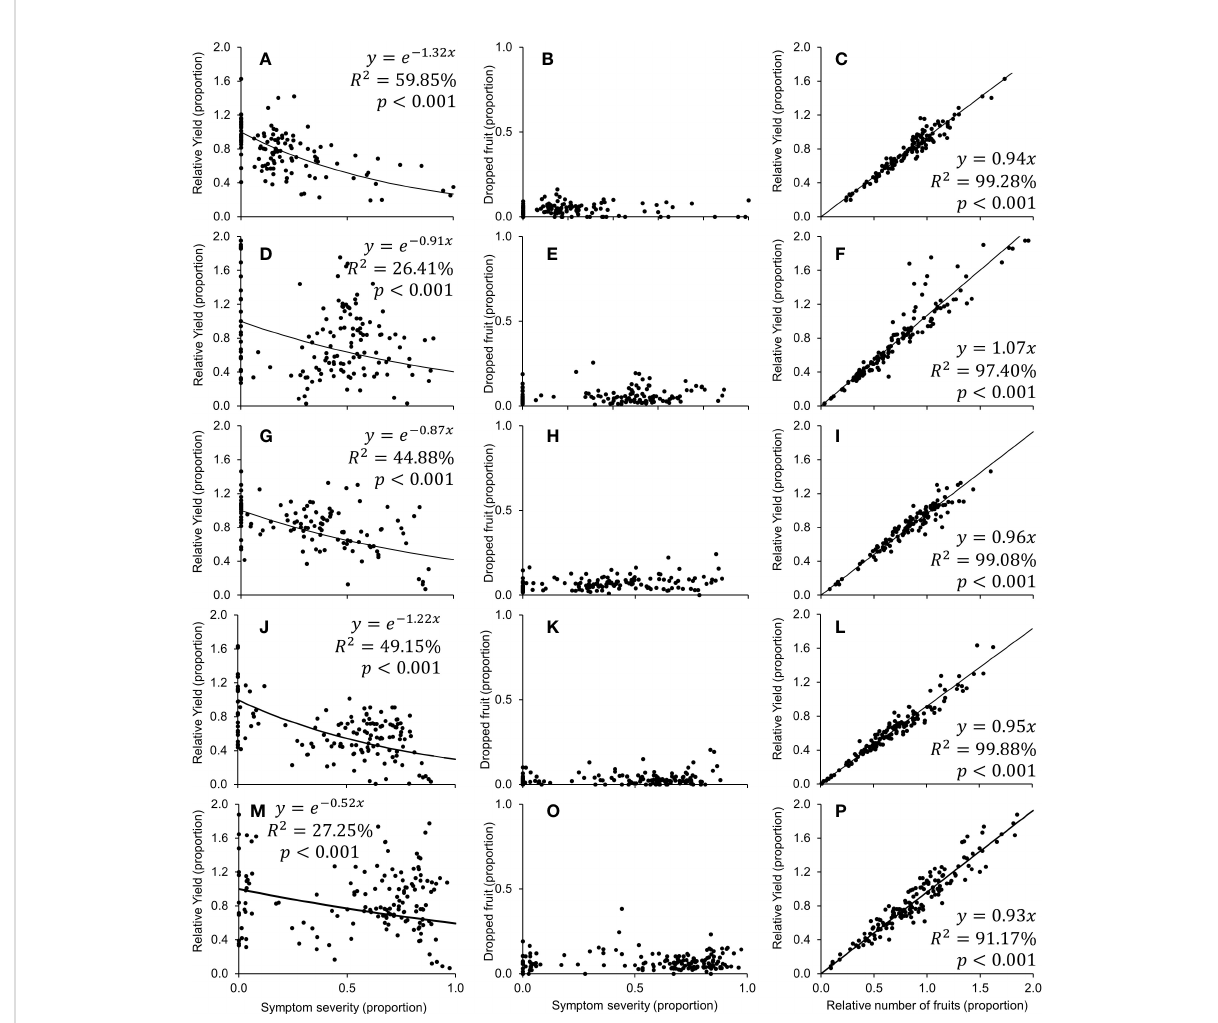
FIGURE 4 Relationship between symptom severity and relative yield [(fruit from HLB + tree)/(fruit from healthy tree)] (A, D, G, J, M) or dropped fruit (B, E, H, K, O) , and between the relative number of fruits [(number of fruits from HLB + trees)/(number of fruits from healthy trees)] and relative yield (C, F, I, L, P) , calculated from the 2017 (A – C) , 2018 (D – F) , 2019 (G – I) , 2020 (J – L) , and 2021 (M – P) harvest season of 5 year-old ‘ Femminello ’ lemon trees.